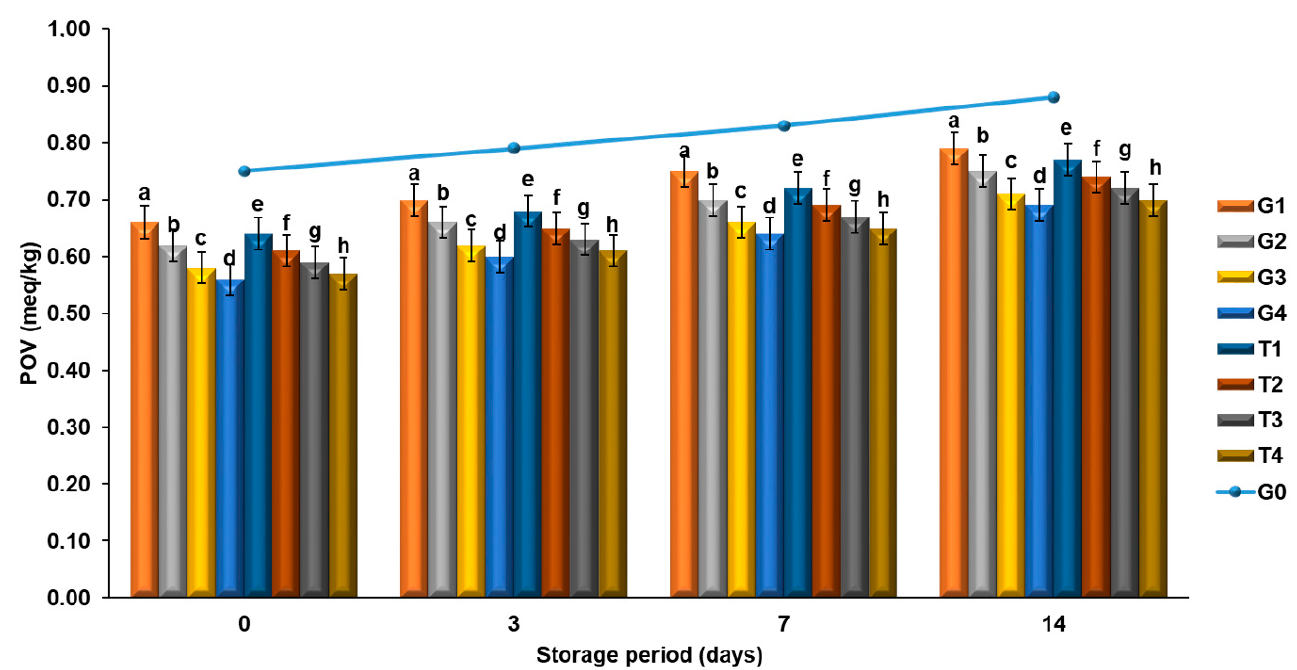
Figure 2. Changes in POV and meatballs during storage. The results are expressed as mean ± standard error. a–h For each day, columns representing different values are labeled with different letters.